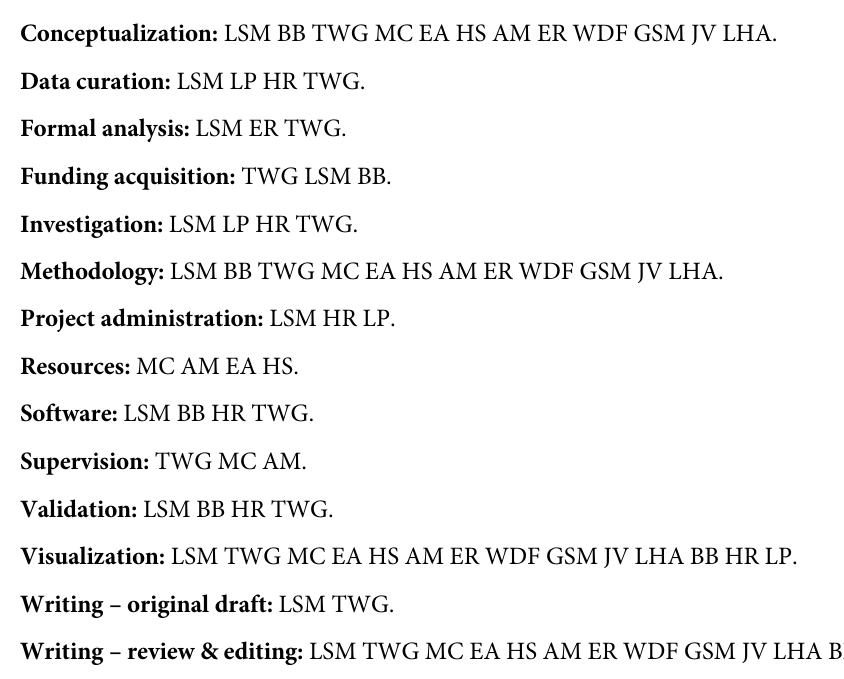
S12 Table. Effect of maternal postpartum deworming on infant morbidity indicators at 1 month of age (N = 1010 (cid:3) ), Iquitos, Peru, (March–September